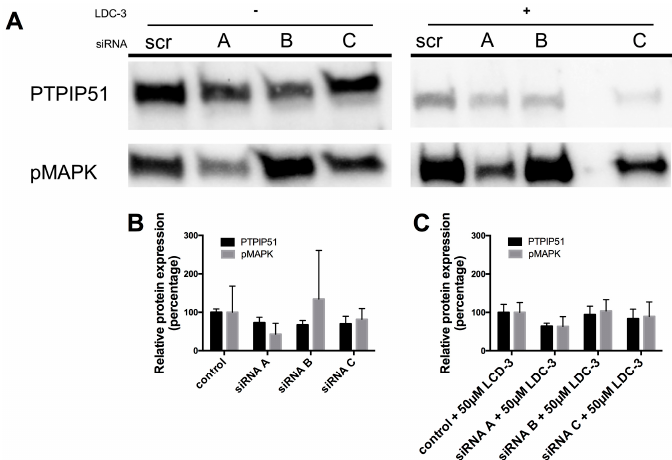
Figure 2. Small interfering ribonucleic acid (siRNA) experiments verifying the specific binding of LDC ‐ 3. ( A ) Cell lysate of all siRNA constructs ( n = 3) were probed with the antibody against protein